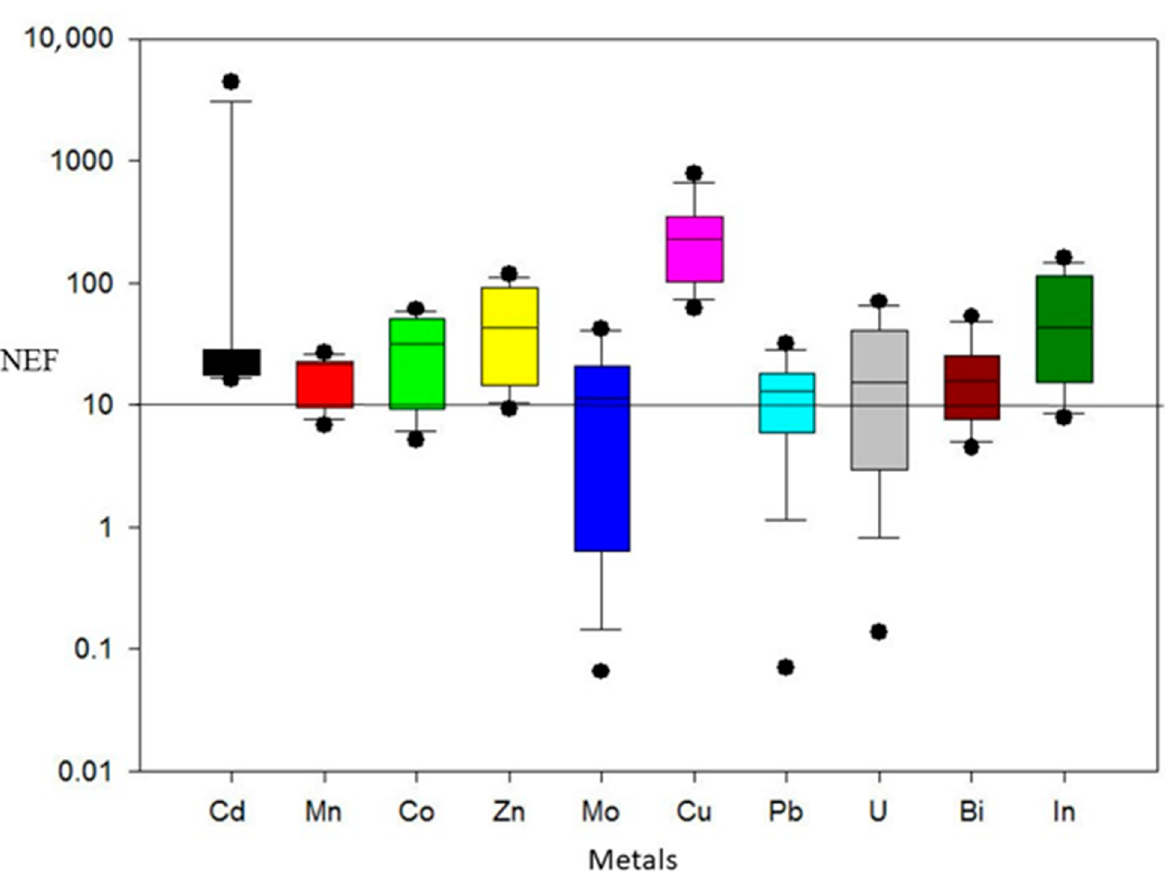
Figure 2. Selected metals showing enriched concentrations in sampling stations of Santa Rosalia, BCS. Cd SD = ± 289.5, Mn SD = ± 4.8, Co SD = ± 22, Zn SD = ± 13.6, Mo SD = ± 13.1, Cu SD = ± 71.4, Pb SD = ± 10.7, U SD = ± 17.6, Bi SD = ± 26.9, In SD = ±